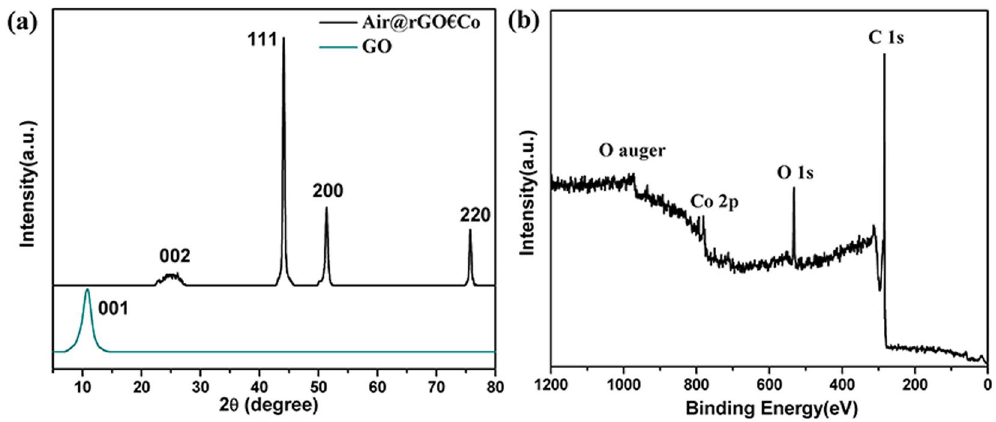
Figure 2. ( a ) XRD patterns of S 1.5 ( b ) The XPS full spectrun of S 1.5